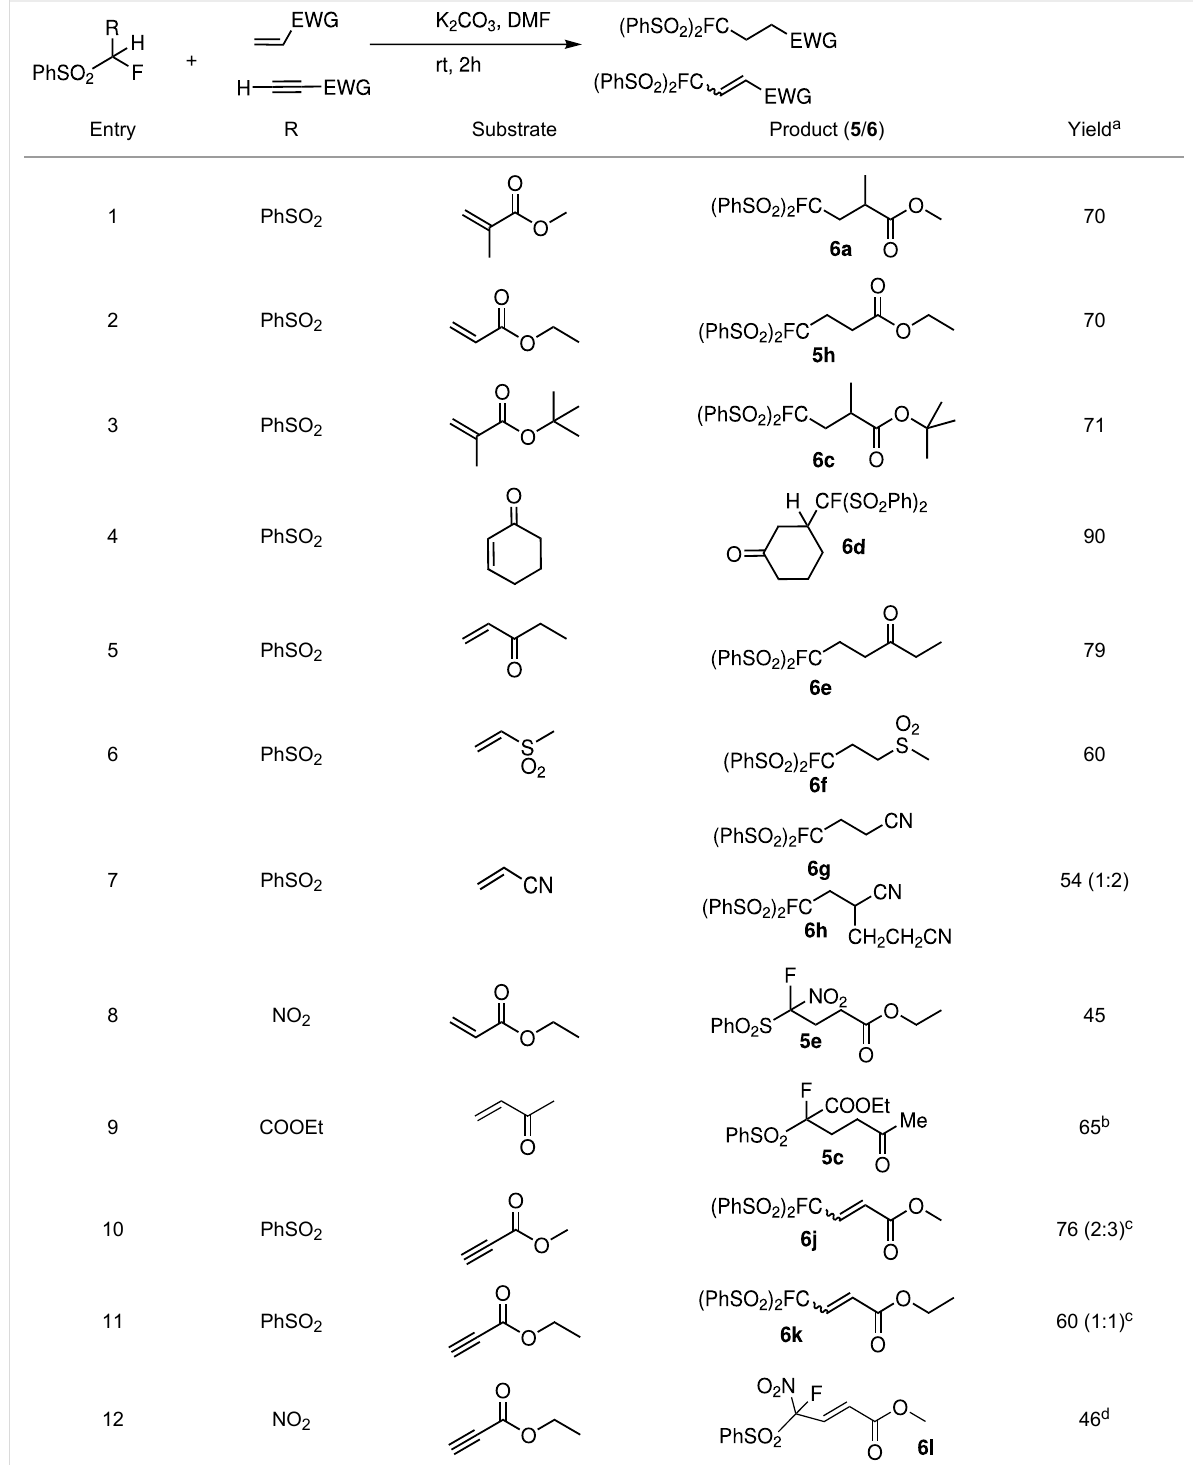
Table 3: K 2 CO 3 /DMF catalyzed 1,4-addition to α,β-unsaturated esters, ketones, sulfone, nitriles and